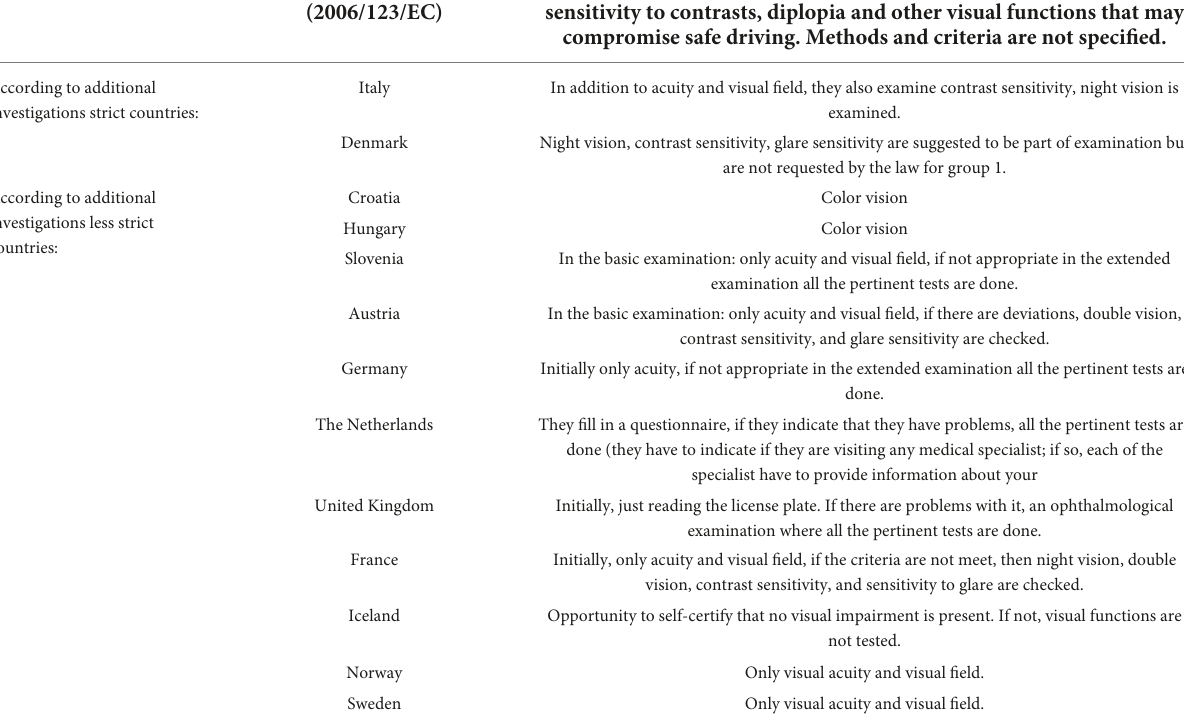
TABLE 3 Requirements of the European Directive regarding additional investigations of visual functions and comparison of the requirements of selected European countries according to the degree of deviation. EU Directive Attention should be paid to vision in low light, sensitivity to glare and (2006/123/EC) sensitivity to contrasts, diplopia and other visual functions that may compromise safe driving. Methods and criteria are not